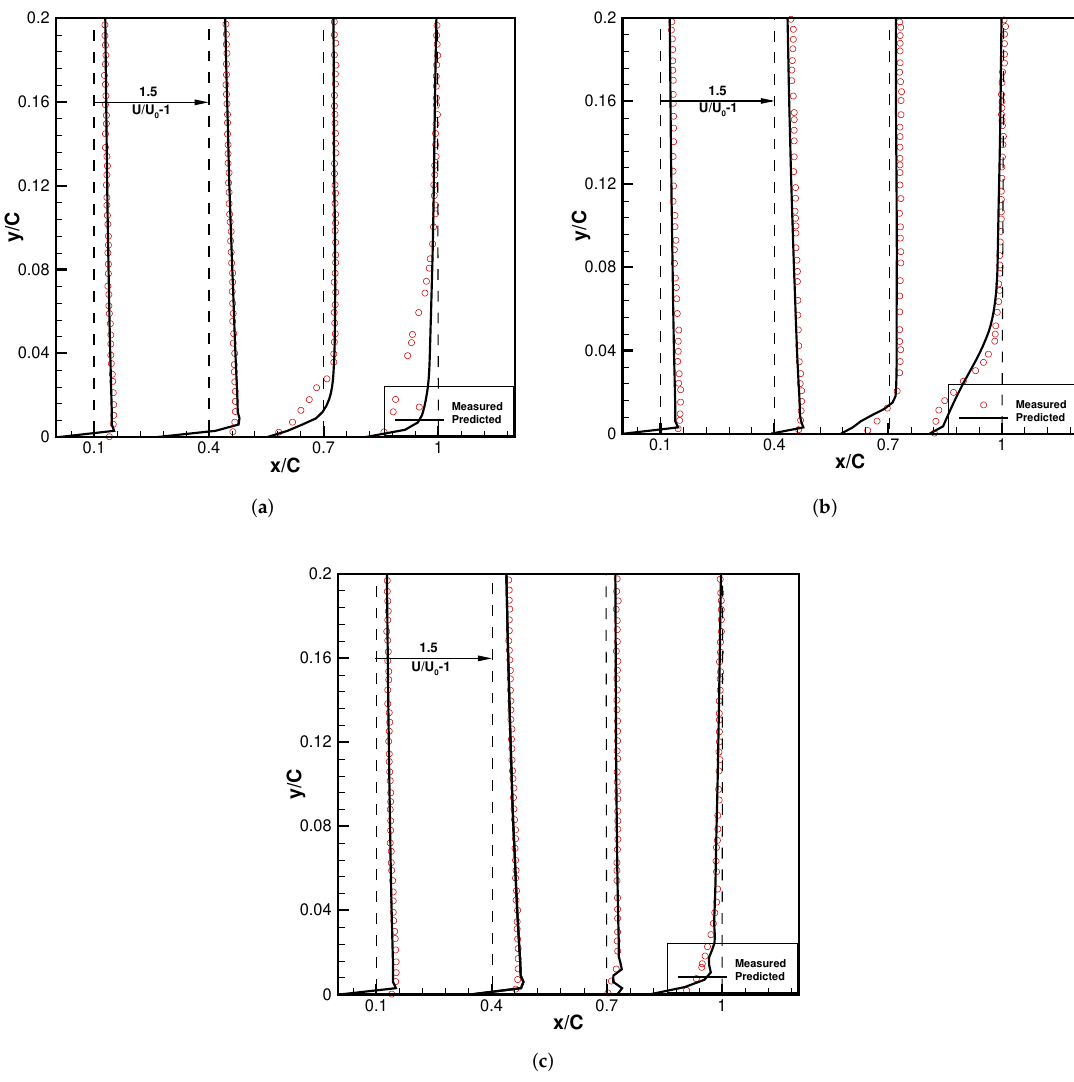
Figure 4. Validation against the experimental data of [4] for angle of attack 3 ( a ) without injection (case AOA3b), ( b ) with mild injection (case AOA3c), ( c ) for high injection (case AOA3d)